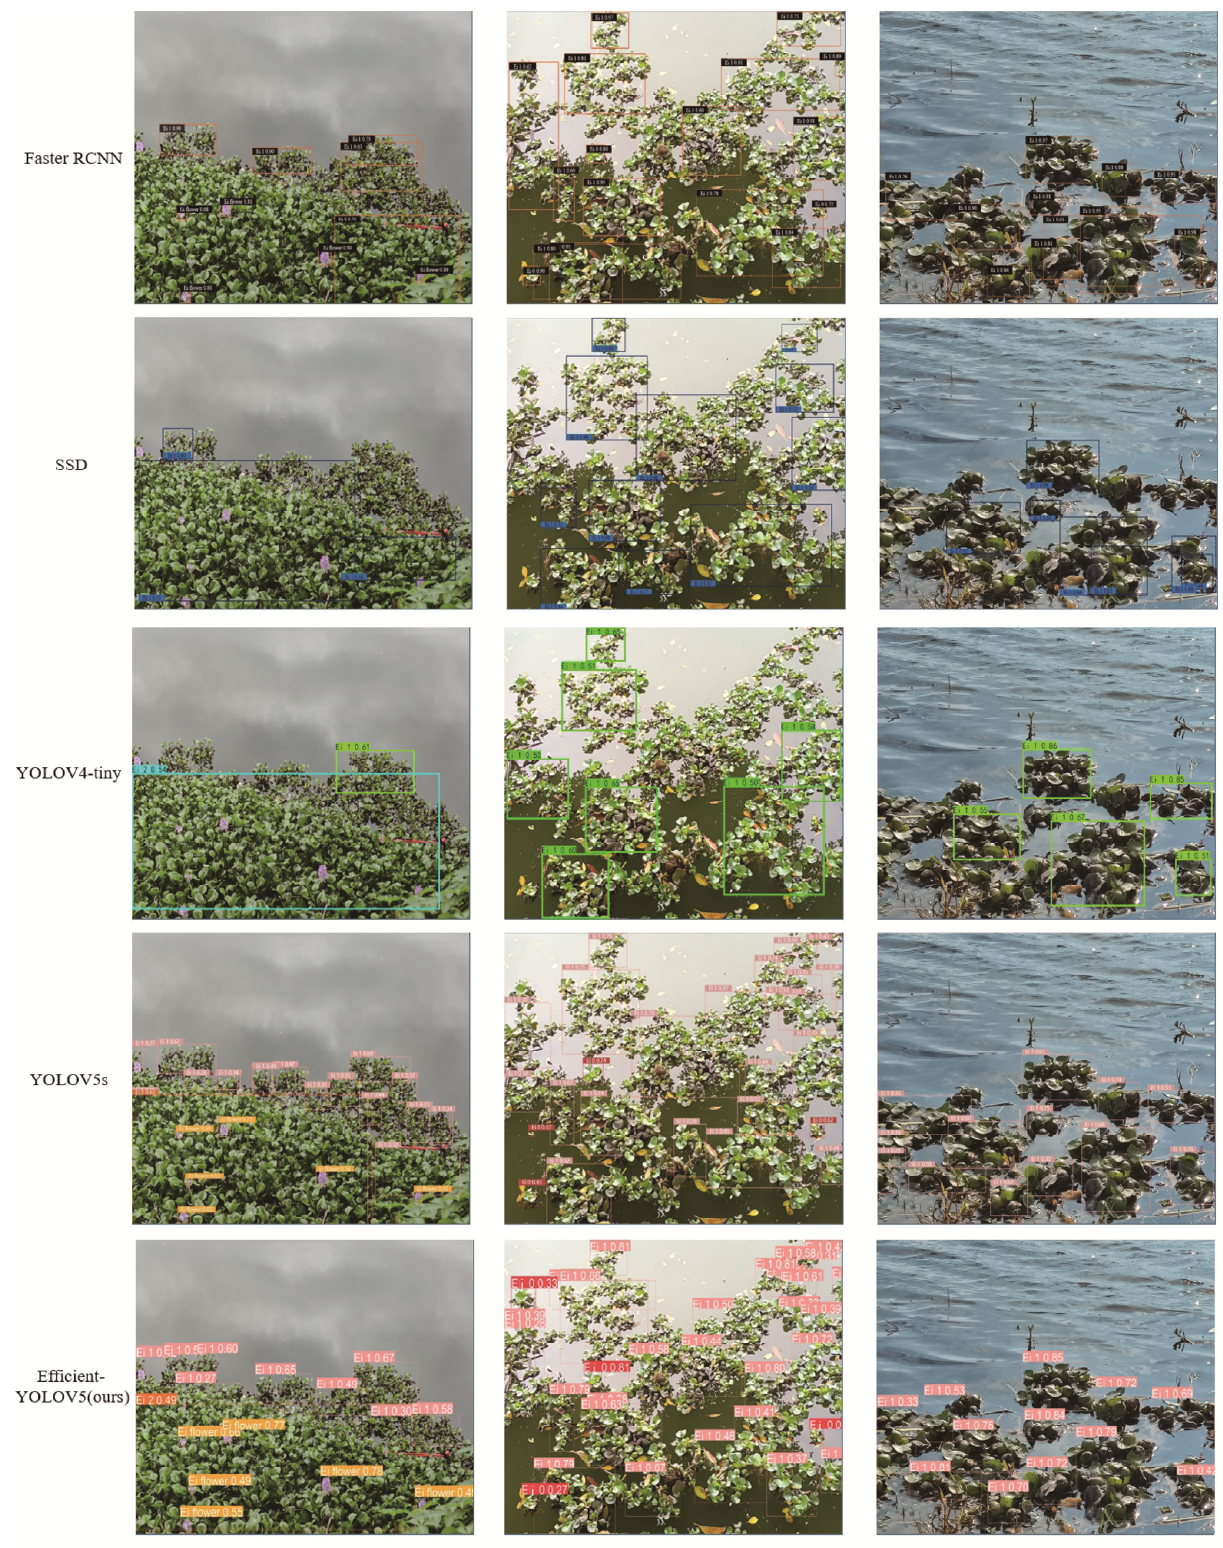
Figure 12. Comparison of detection effects of different algorithms.